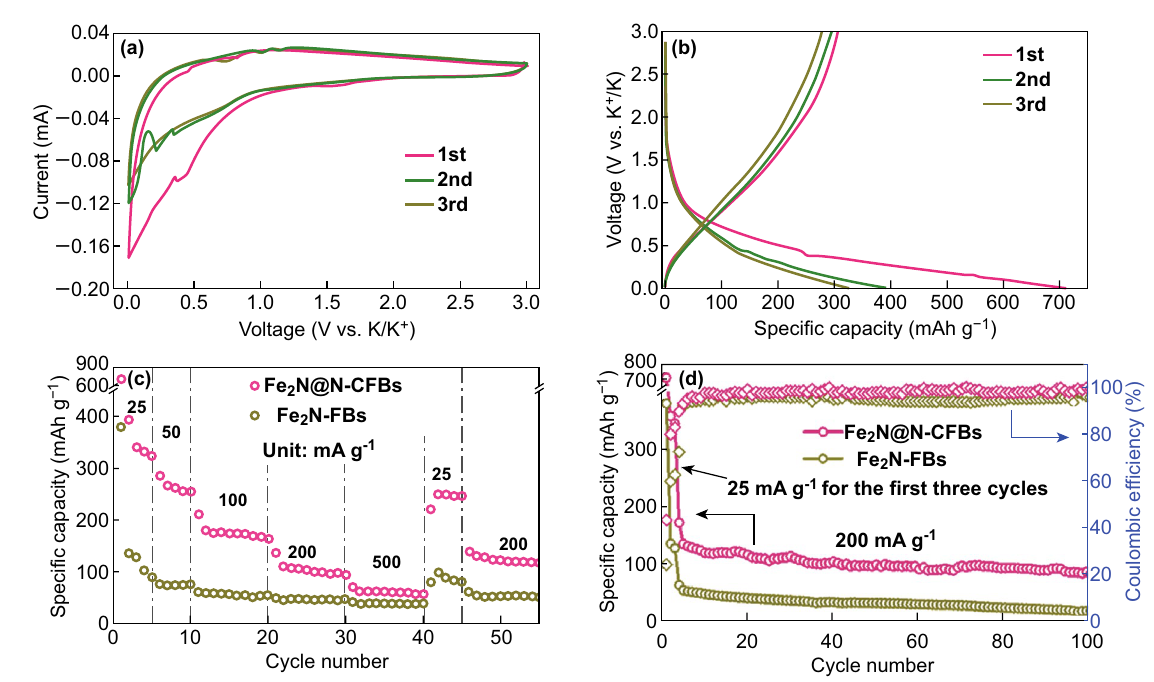
Fig. 6 Potassium-ion storage properties of Fe 2 N@N-CFBs. a CV curves and b discharge–charge profiles at 25 mA g −1 for Fe 2 N@N-CFBs in the first three cycles. c Rate capabilities of the Fe 2 N@N-CFBs and Fe 2 N-FBs electrodes at varied current density. The presented capacities are discharge capacities. d Cycling performances of the Fe 2 N@N-CFBs and Fe 2 N-FBs electrodes for 100 cycles at 200 mA g